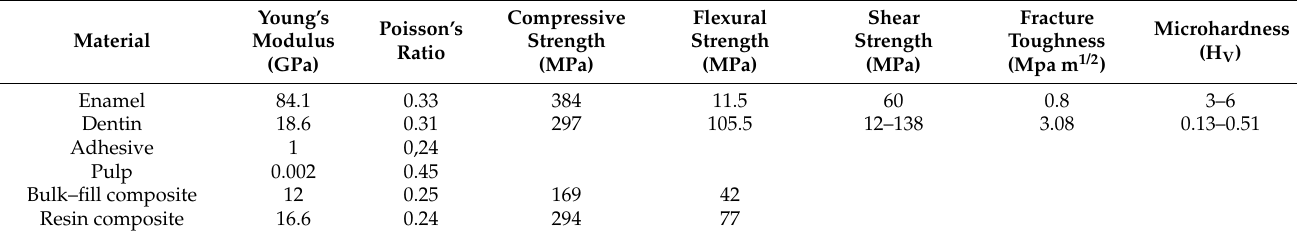
Table 2. Mechanical properties of dental tissues and restorative materials